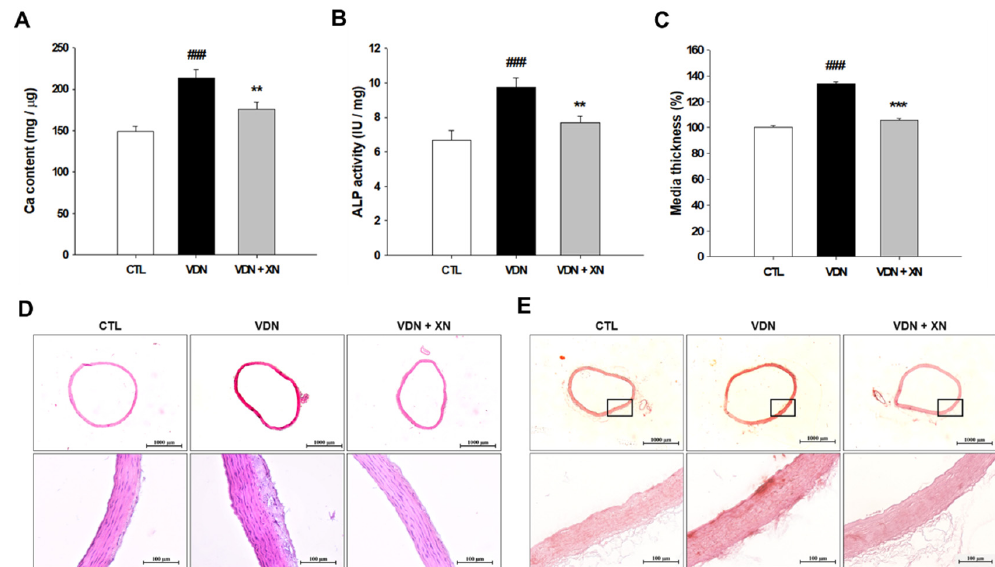
Figure 4. Effects of XN on aortic mineralization and osteoblastic phenotype. (A) Calcium content, (B) ALP activity, and (C) media thickness. Histopathological staining of rats’ aorta (D) hematoxylin and eosin staining and (E) Alizarin red S staining (20× and 200× magnification). Each point represents the mean ± SEM, n = 10. ### p < 0.001 compared with the control group. ** p < 0.01, *** p < 0.001 compared with the VDN group.